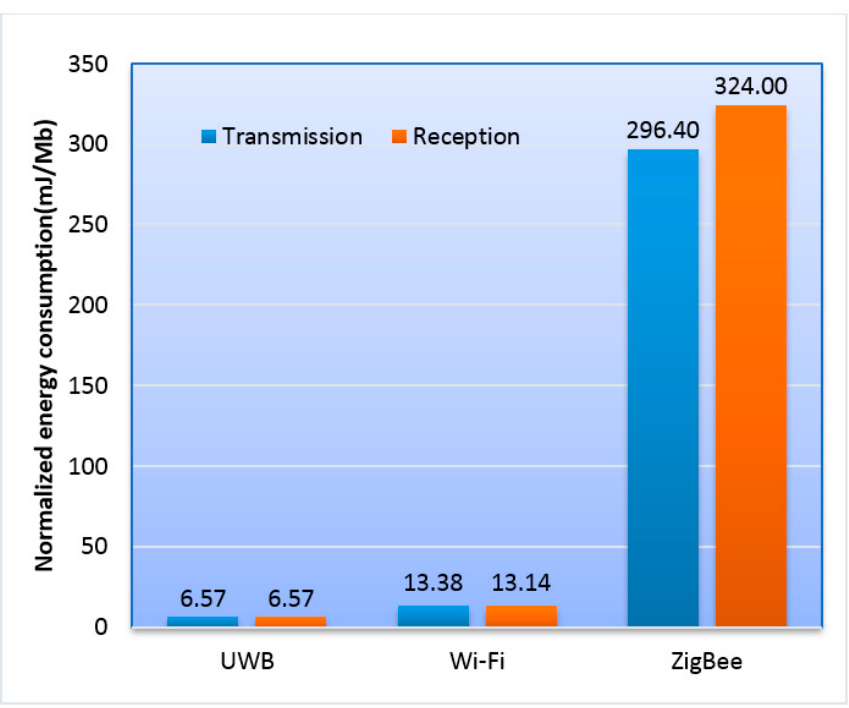
Figure 3. Comparison of UWB, Wi-Fi and ZigBee in normalized energy consumption by choosing four typical wireless products from [27].